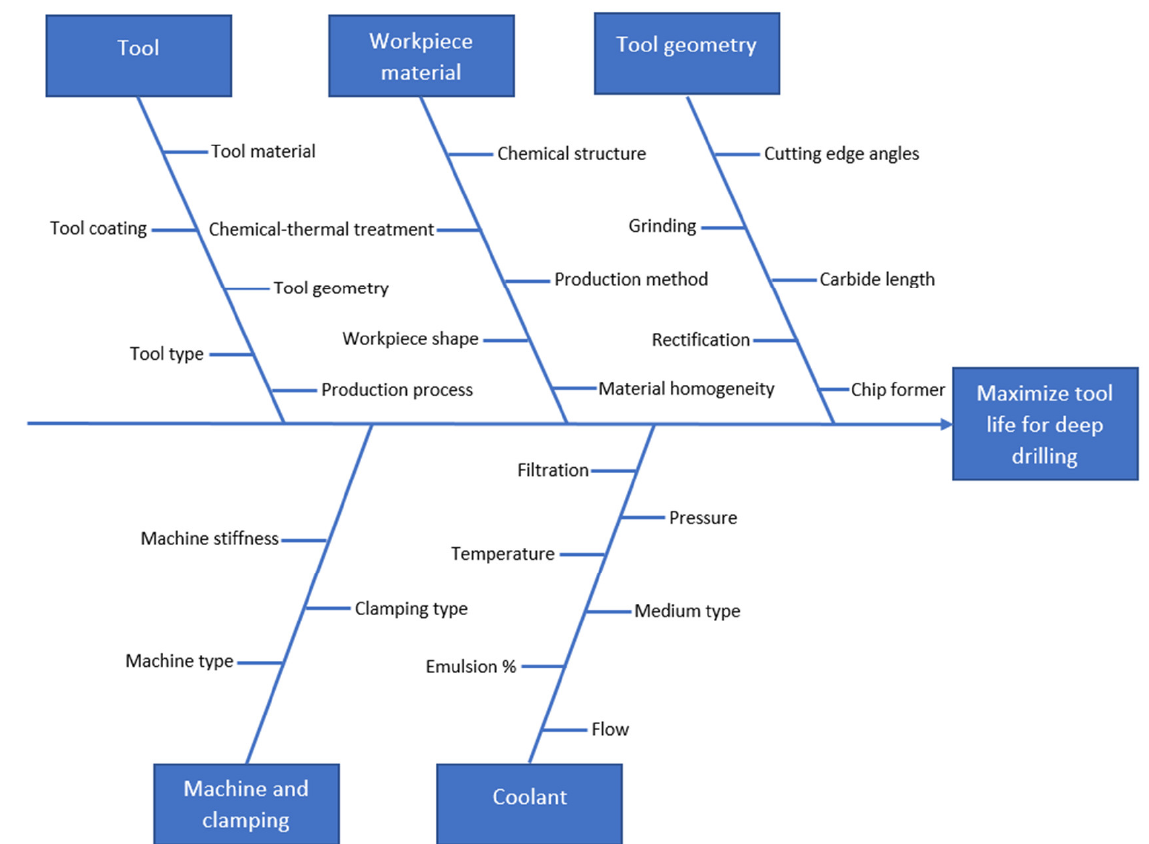
Figure 2. Ishikawa diagram.